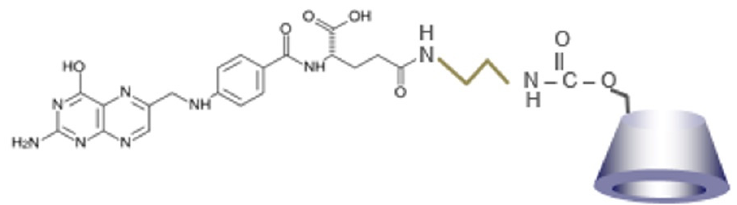
Figure 1. Chemical structure of FA-HP- β